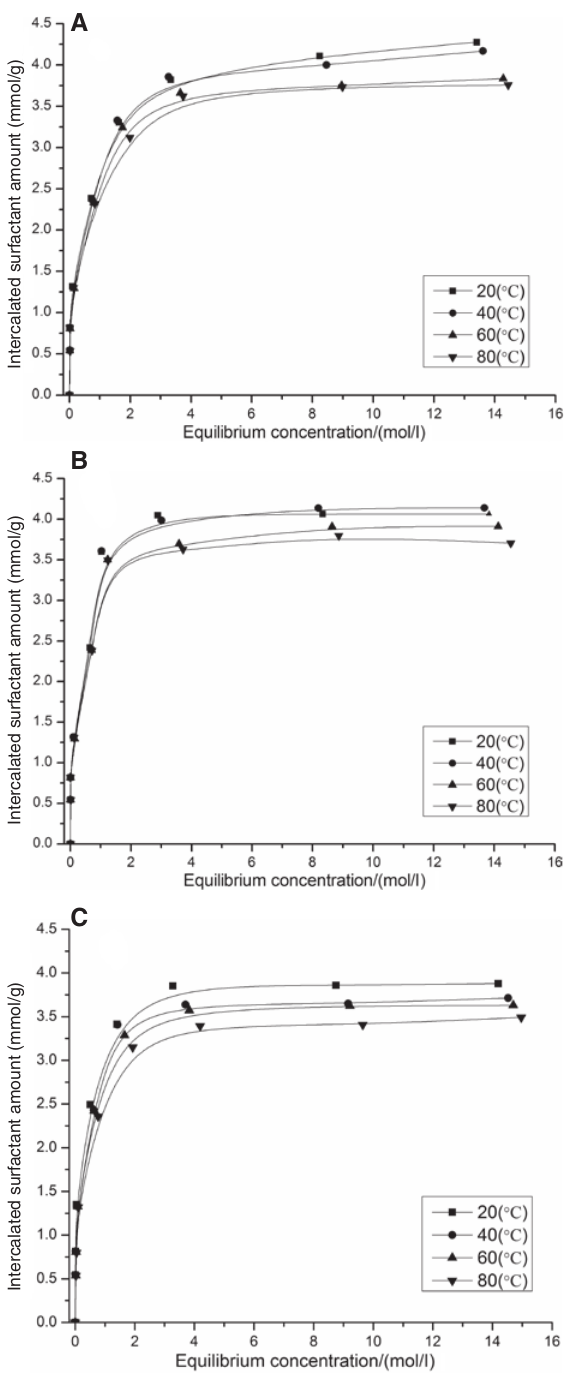
TAB (A), C TAB (B) and C 12 14